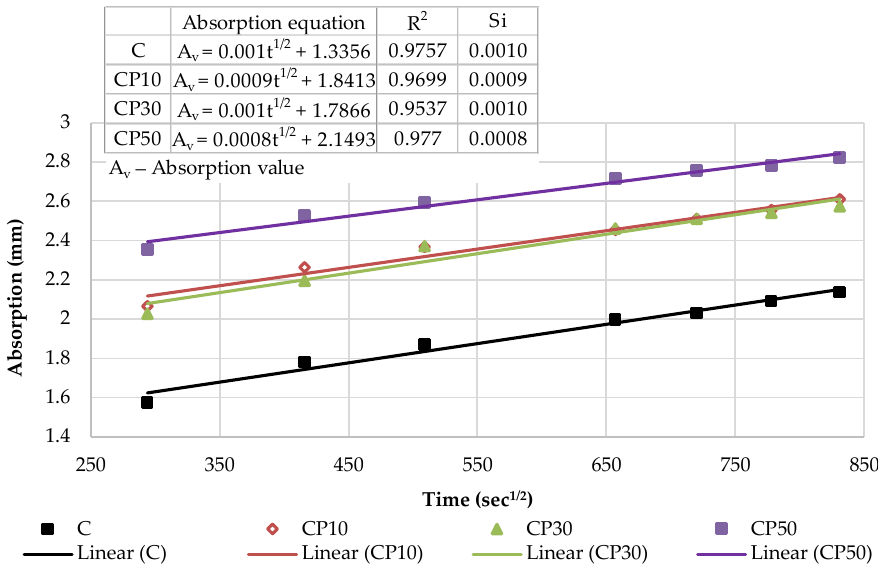
Figure 11. The secondary capillary absorptivity of CP–based mortars.